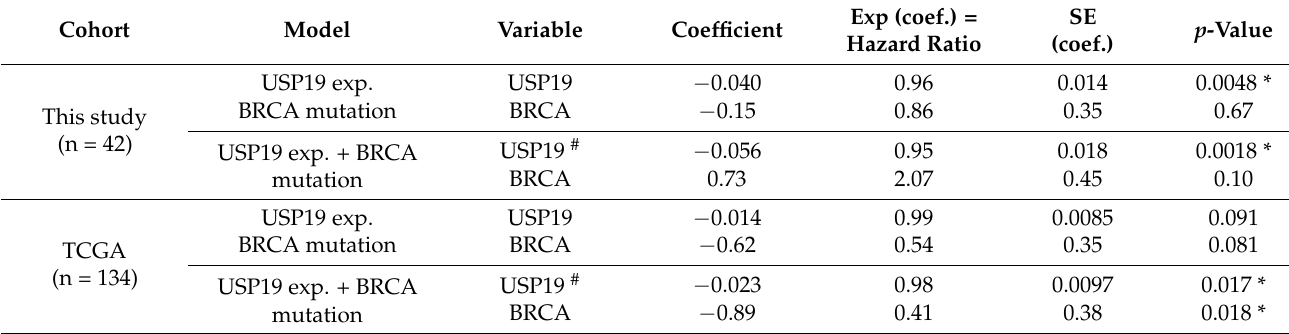
Table 3. Cox regression analysis for investigating the correlation between USP19 expression and BRCA1/2 mutation and progression-free